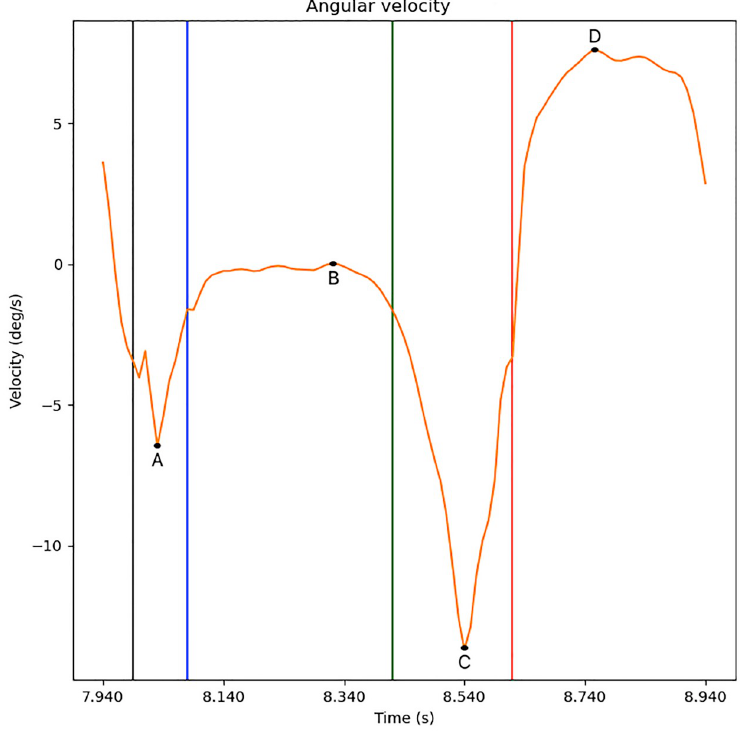
Fig 3. Key events of the support phase of a gait cycle. The events are represented by vertical lines. From left to right: Heel Strike (black), Foot Flat (blue), Heel Off (green) and Toe Off (red). Pairs of local extrema (A, B) and (C, D) define bars in the signal’s persistence